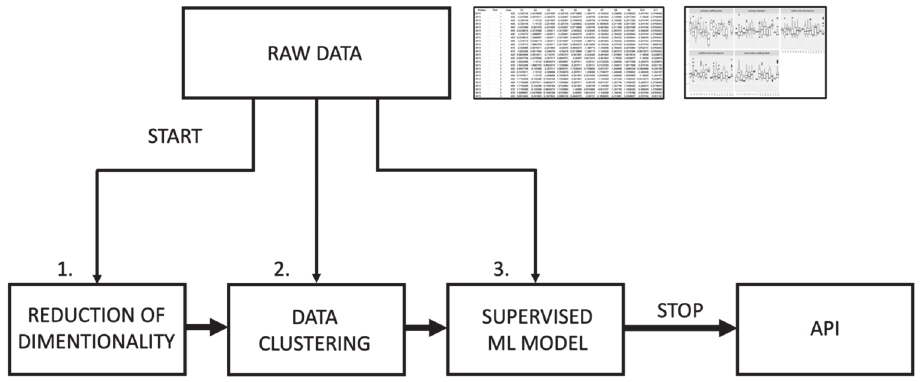
Figure 1. Research